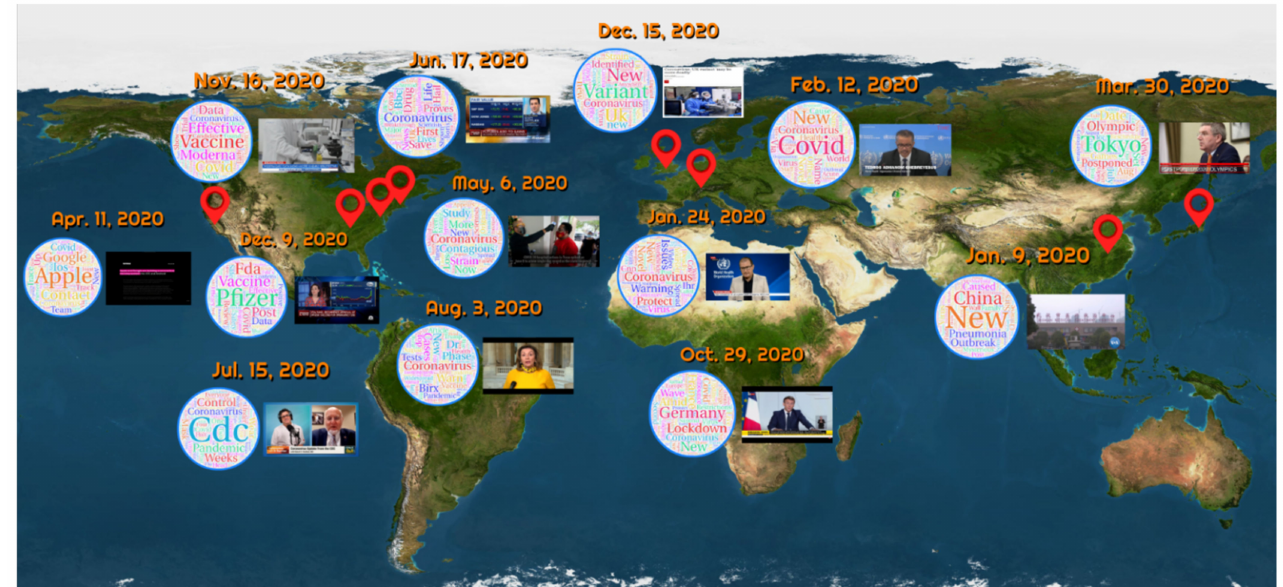
Figure 5. Representation of a map of generated summaries related to COVID-19 events in